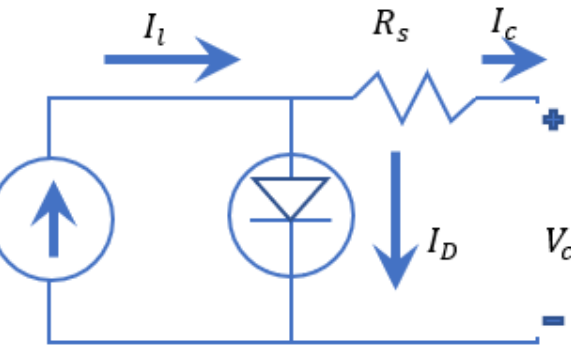
Figure 1. Modeling of a solar cell with series resistance.